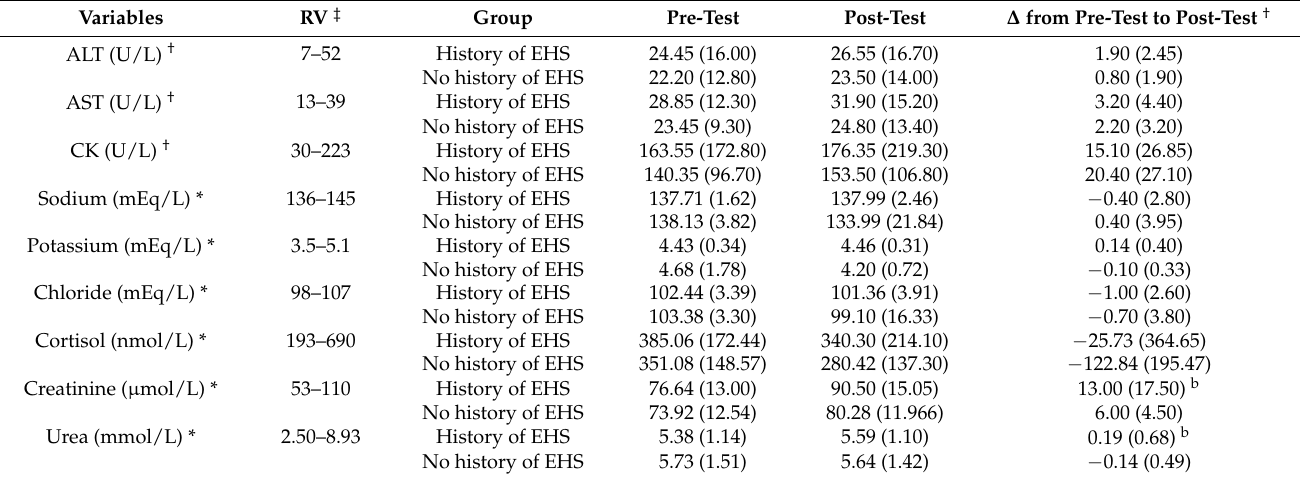
Table 4. Differences in biochemical and hormonal variables between participants with and without a history of